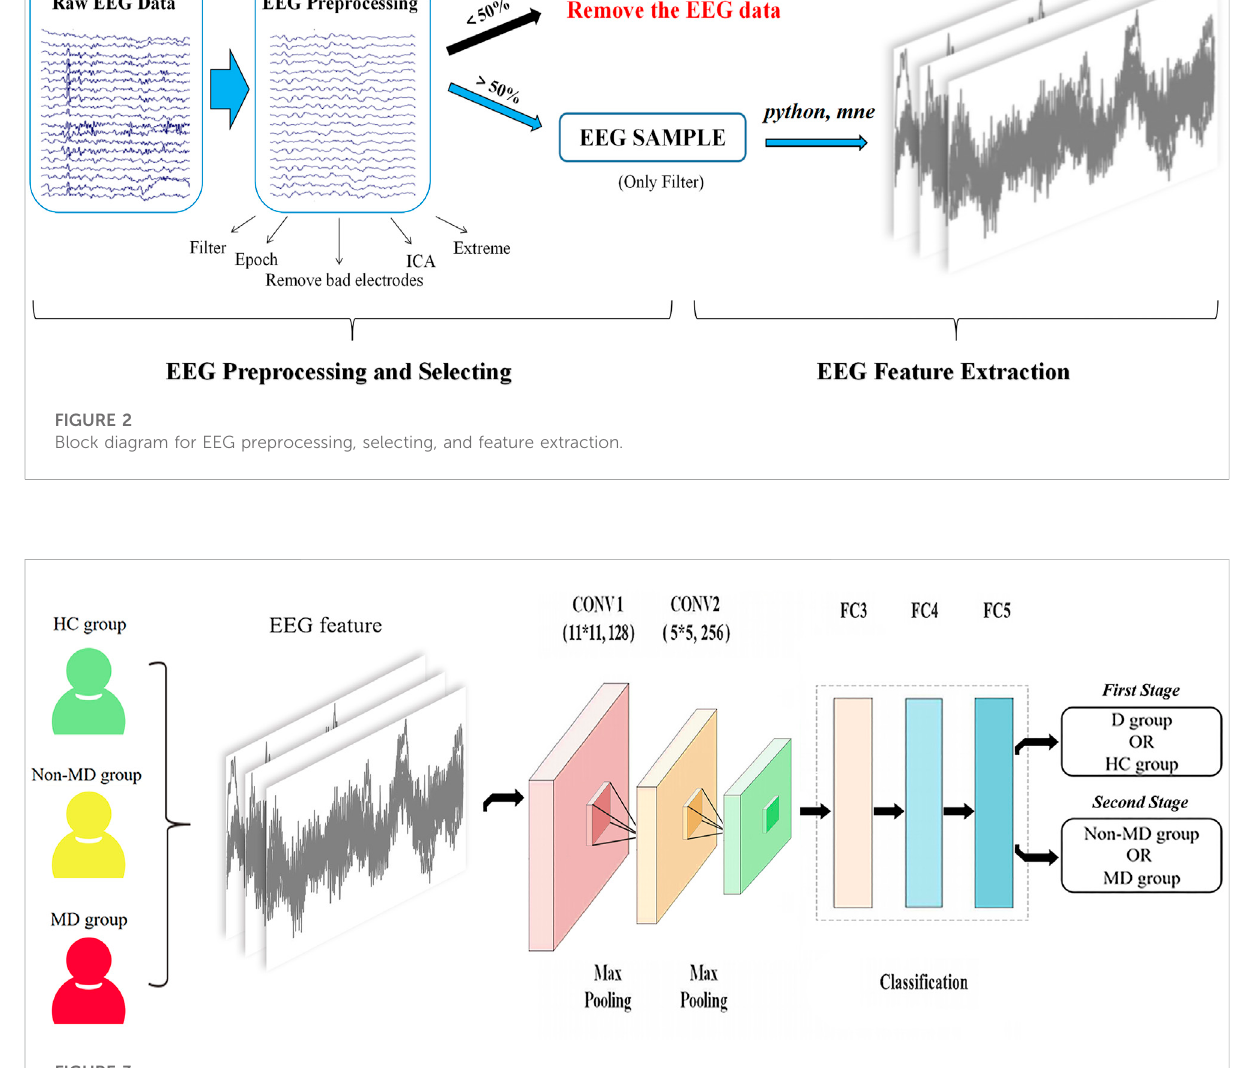
FIGURE 3 Illustration of the EEG-based CNN for diagnosis of depression and its severity. Note: 1) D group, depression group; HC group, health control group; non-MD group, non-major depression group; MD group, major depression group. 2) CONV1 (11*11, 128): 11*11 represents the size of the convolution kernel, representing height and width, respectively, and 128 represents the number of convolution kernels; CONV2 (5*5, 256): 5*5 represents the size of the convolution kernel, representing height and width, respectively, and 256 represents the number of convolution